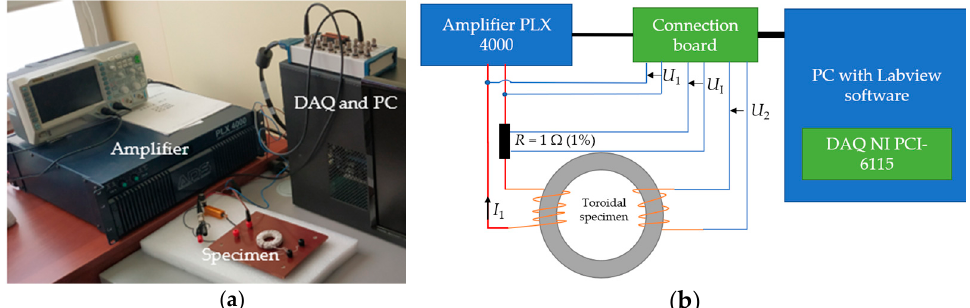
Figure 10. Test stand for measuring magnetic properties, ( a ) view of the magnetic properties measuring system, ( b ) scheme of the test stand.